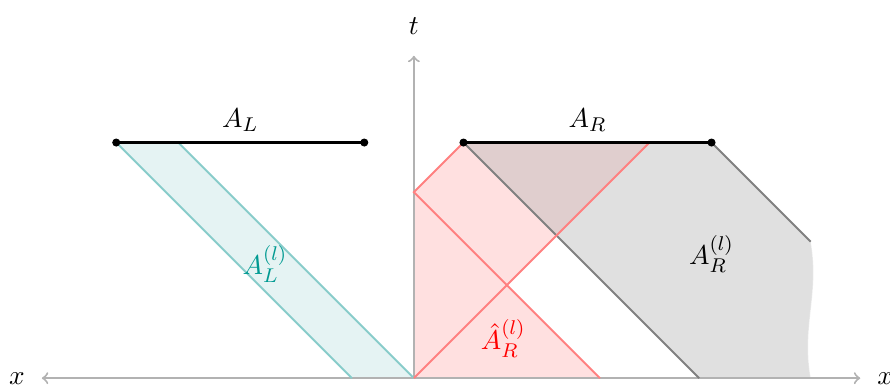
Figure 14 . The left-moving modes that pass through A L ∪ A R at time t are split into the three subsets as indicated. Here, t is in the temporal interval (IV).